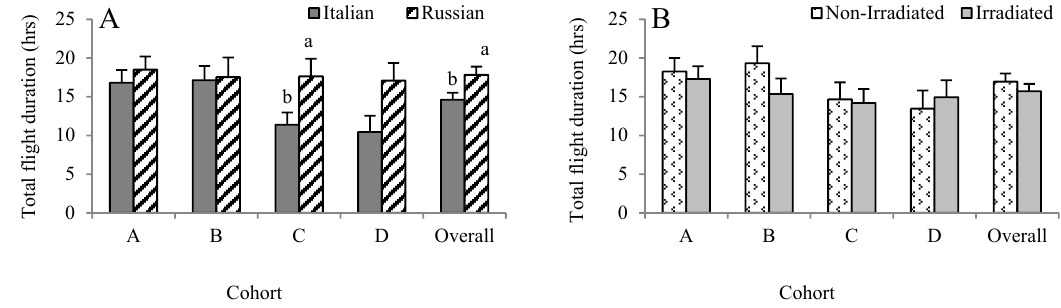
Figure 4. Effects of honey bee stock ( A ) and comb irradiation ( B ) on total duration of foraging flights (mean ± standard error). For each cohort, bars with the same letters are not significantly different ( p > 0.05).